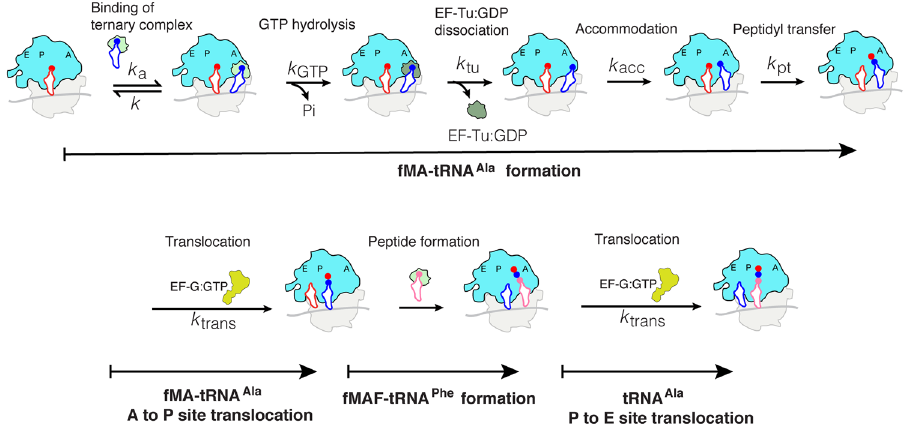
Figure 2. Schematic illustration of the kinetic steps in tripeptide synthesis. The EF-Tu:GTP:Ala-tRNA Ala ternary complex was added to the 70S initiation complex and the mean time for GTP hydrolysis on EF-Tu was measured. After GTP hydrolysis and ET-Tu:GDP was dissociated from the ribosome, the Ala-tRNA Ala was accommodated to accept the fMet to form the fMA dipeptide. The mean time for fMA-tRNA Ala formation was measured. After the formation of fMA-tRNA Ala , this dipeptidyl-tRNA was translocated from the A site to the P site by EF-G and could then donate the fMA dipeptide to the incoming A site Phe-tRNA Phe to form the fMAF tripeptide. The resulting P site deacylated tRNA Ala was translocated to the E site along with the peptidyl- tRNA Phe translocating to the P